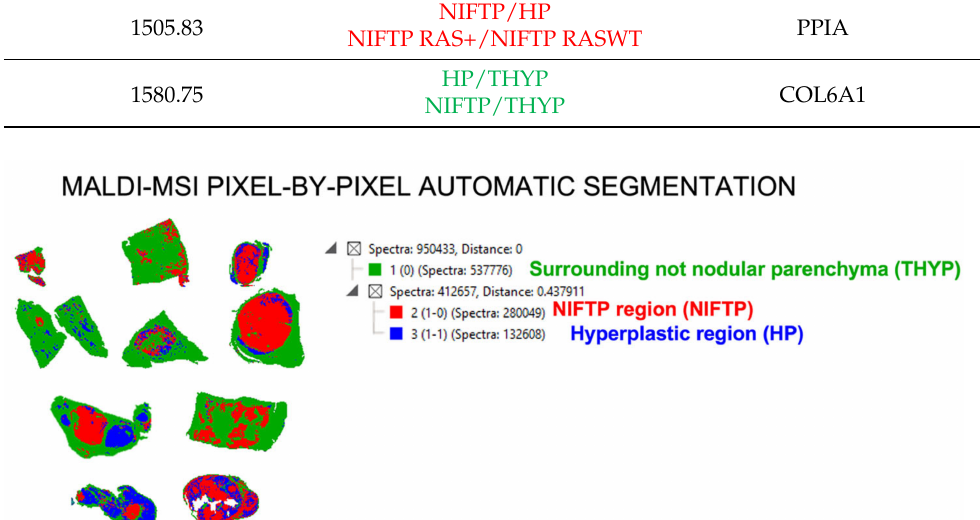
Figure 3. Molecular maps obtained with a K-Means approach starting from the 10-peptide signature discovered with MALDI–MSI. This demonstrates the capability of this approach to identify the NIFTPs (red areas) from the remaining structures (HP and